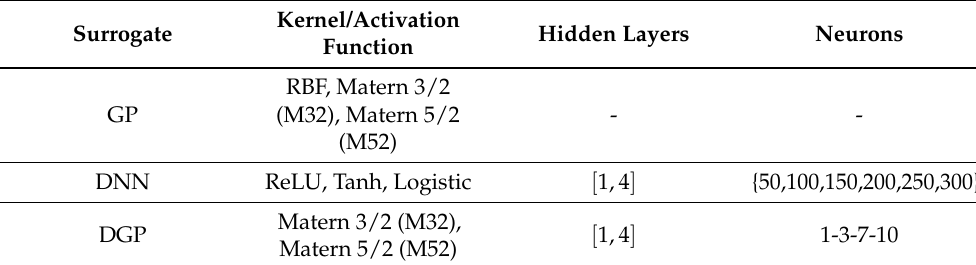
Table 9. Studied hyperparameters for the three surrogate models. Kernel/Activation Hidden Layers Surrogate Function